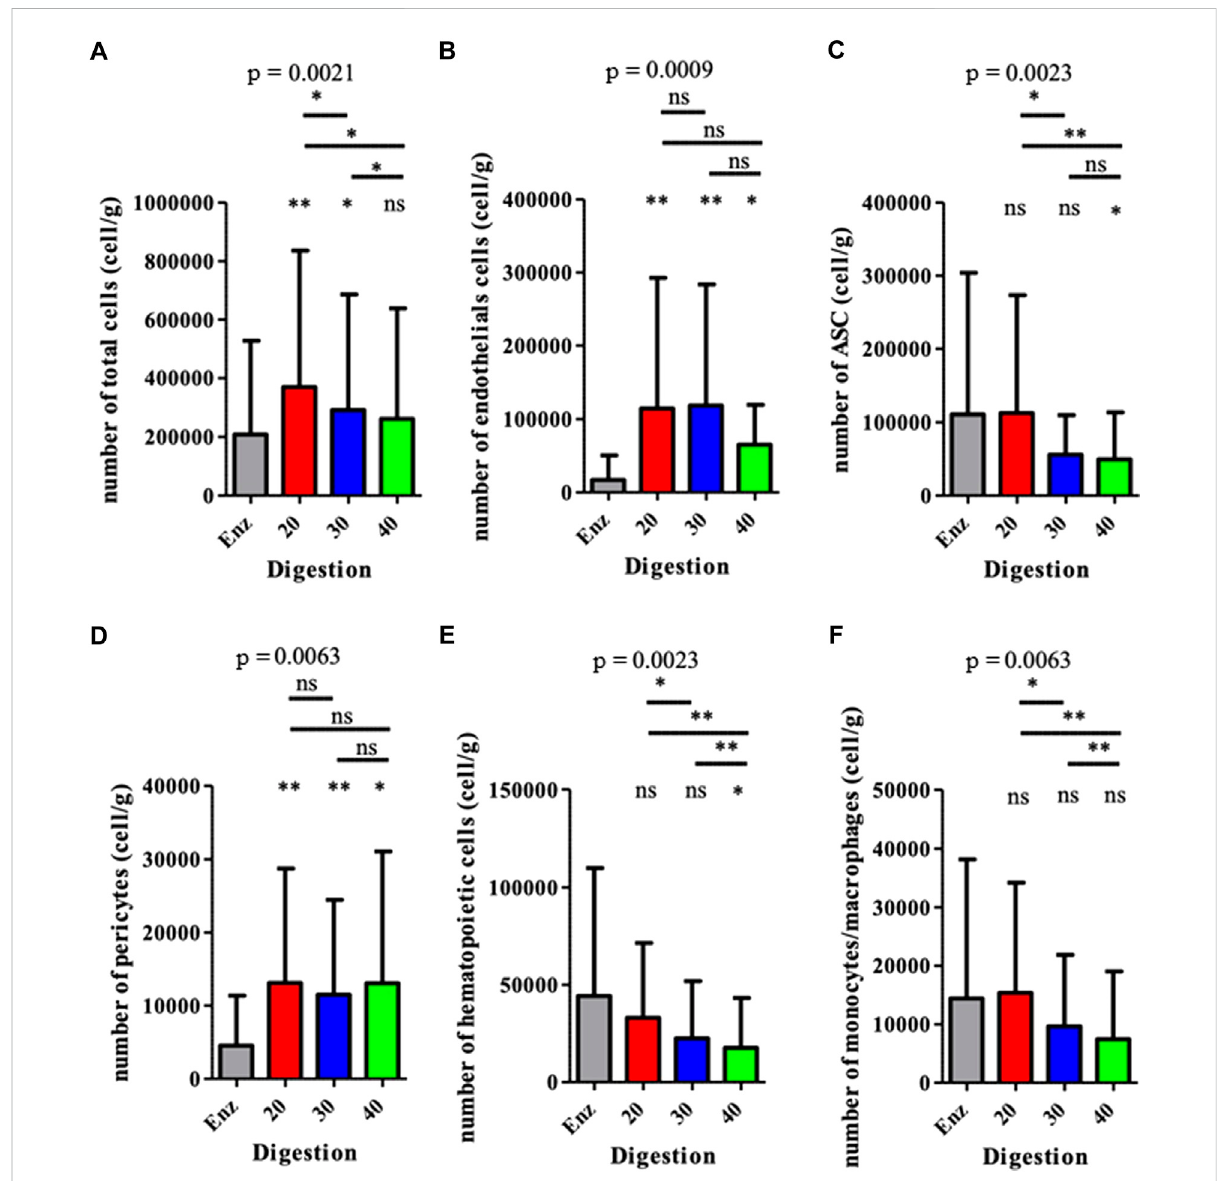
FIGURE 2 Analysis of the cell populations from each SVF obtained for various methods. The results are expressed as the number of cells per gram of the initial fresh tissue. * p < 0.05, ** p < 0.001, and *** p < 0.0001; ns: not signi fi cant. SVF: stromal vascular fraction.